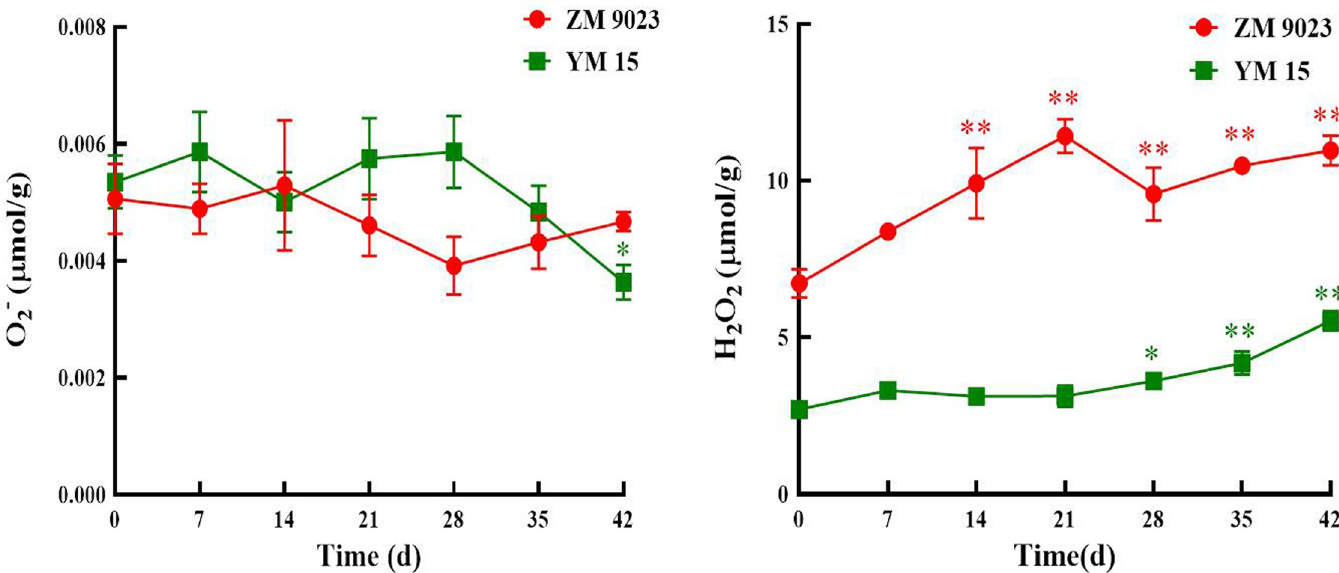
Fig 3. Changes in the superoxide anion (O2 − ) and hydrogen peroxide (H 2 O 2 ) contents of the wheat cultivars ZM 9023 and YM 15 during artificial aging. At least three independent experiments were performed; data are shown as mean ± SD. � p < 0.05; �� p < 0.005.